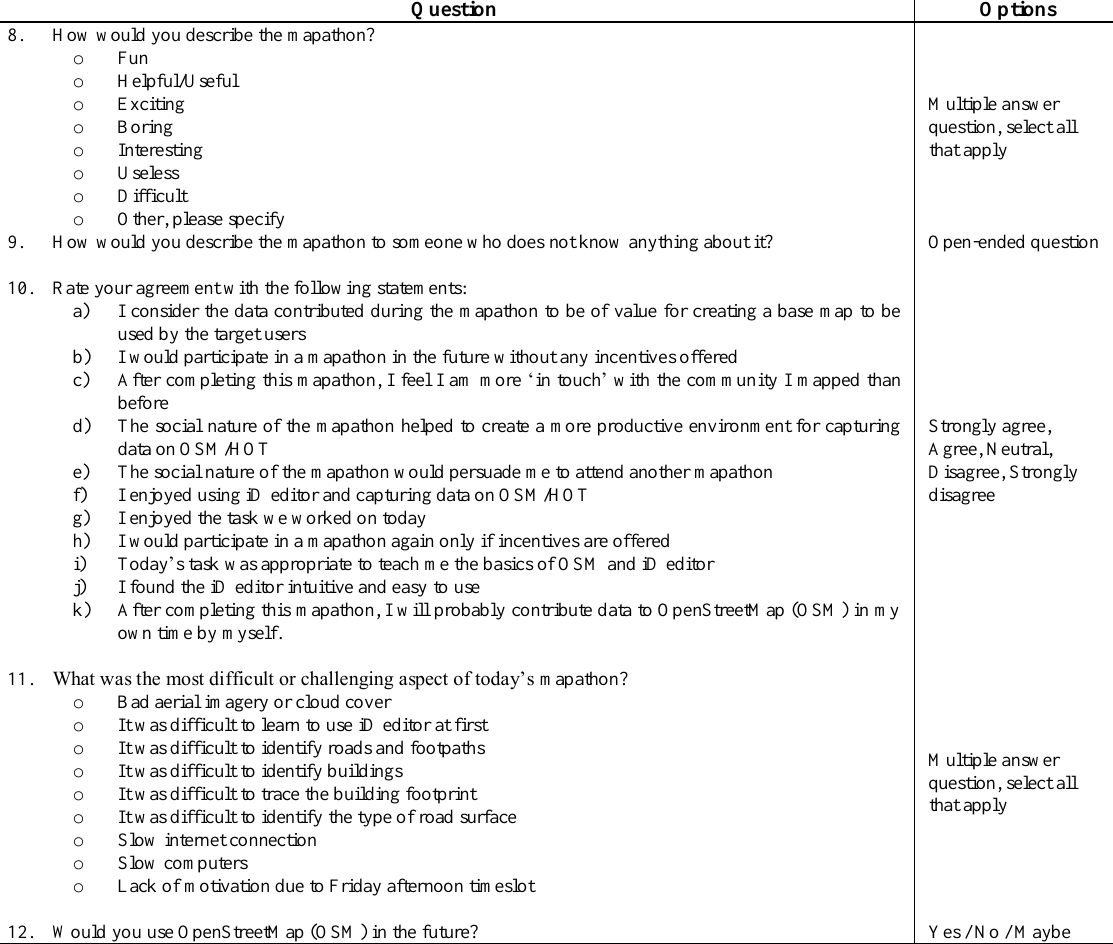
Table 3. Questionnaire on motivations and opinions (continue)